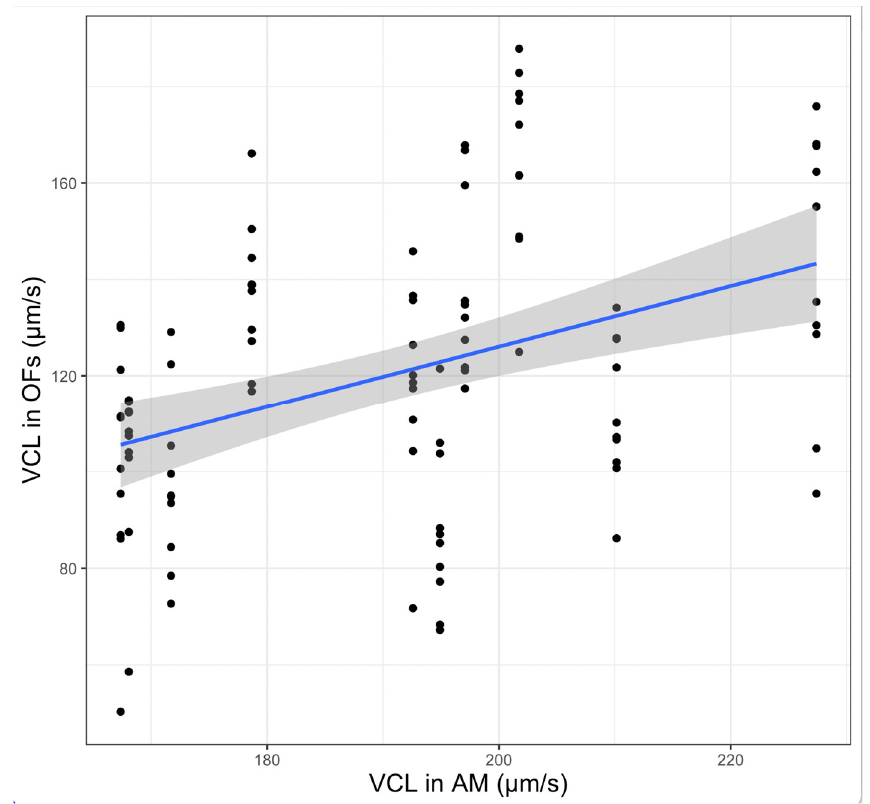
Figure 2. The VCL (curvilinear velocity) values registered in all OFs (native and zootechnical) are significantly correlated to those registered in AM ( p < 0.05). The blue line represents the fitted linear regression and the dark shadow shows the 95% confidence interval band.